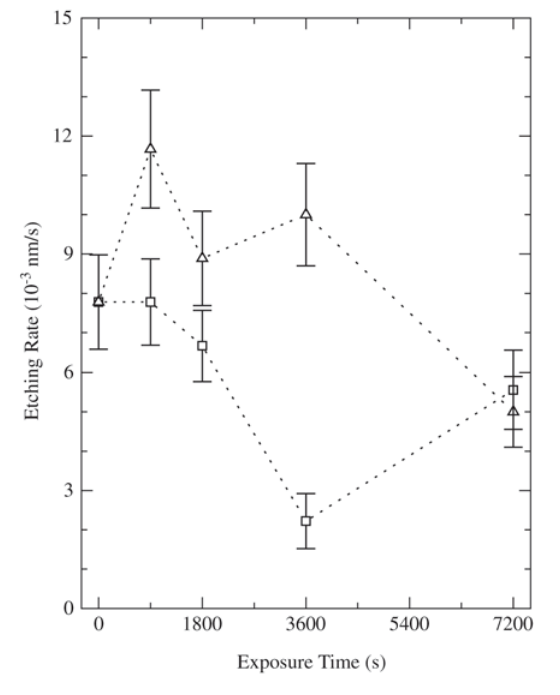
Figure 4. Etching rate of films implanted with nitrogen or helium ions as a function of t .